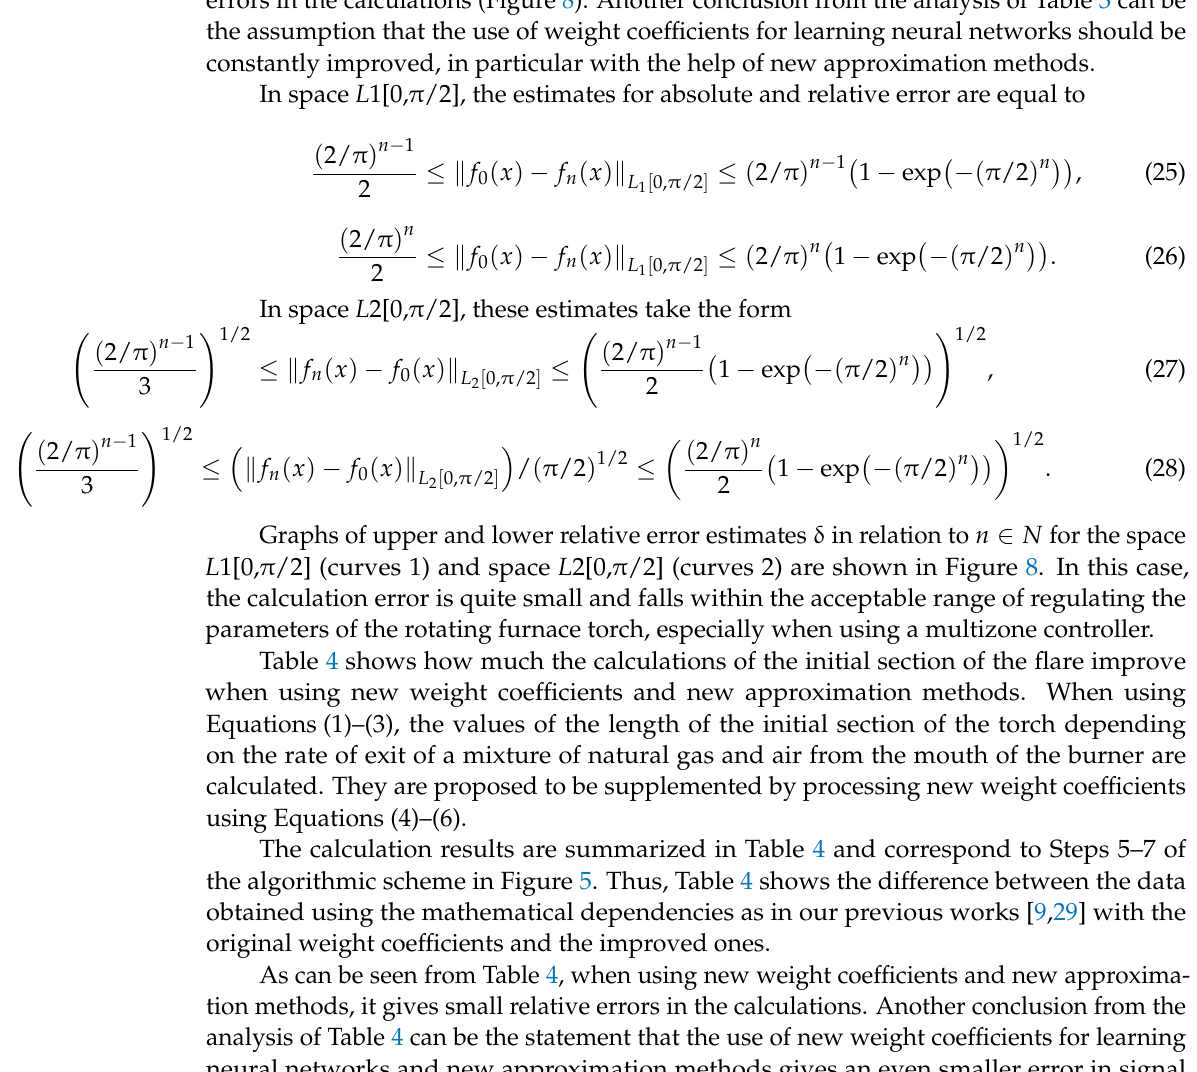
Table 4. Results with new weight coefficients, as well as using new approximation methods.